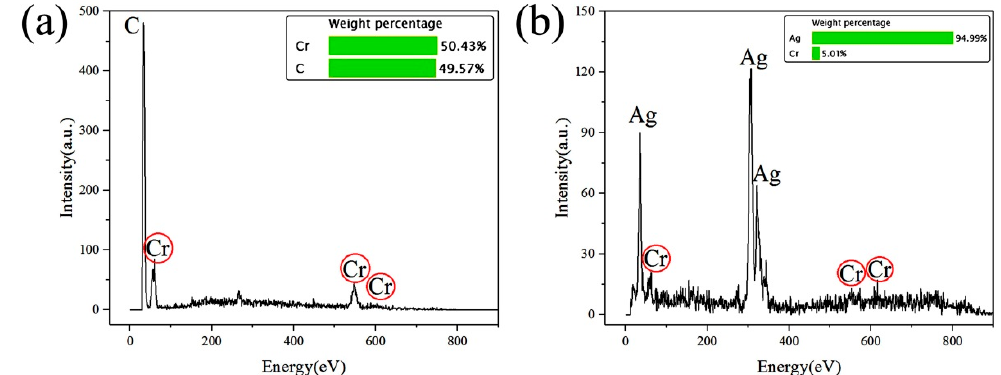
Figure 9. Energy dispersive spectrometer (EDS) images. ( a ) Surface components of original PVC mold side; ( b ) surface components of the nickel mold side.